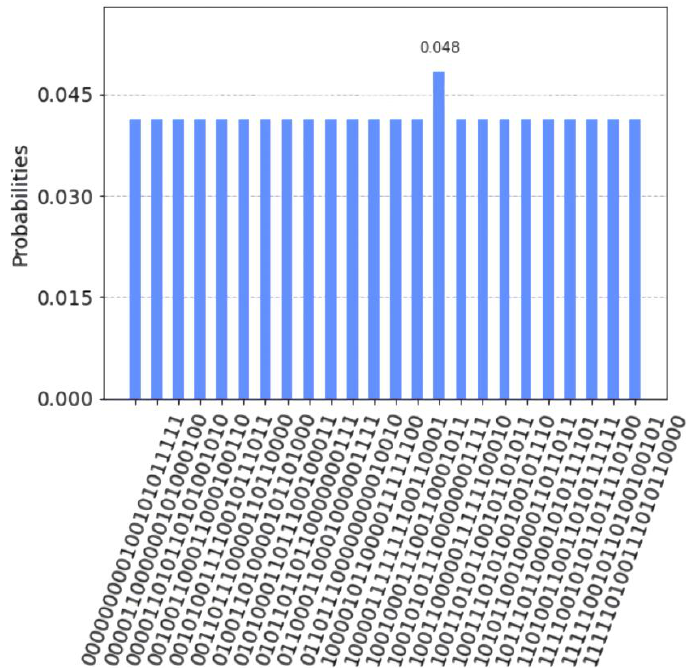
Figure 13. The results of three iterations of the twenty-one variable Boolean equation system. To fully understand the relationship between the number of qubits and quantum cir- cuits, Qiskit was used to solve Boolean equations on different scales many times, and the experimental results were recorded. Table 2 lists the number of qubits and the average quantum circuit depth (three iterations) used for Boolean equations on different scales (starting with ten variables). Table 2. Number of qubits and circuit depth required for Boolean equations of different scales. The Scale of Boolean Equations